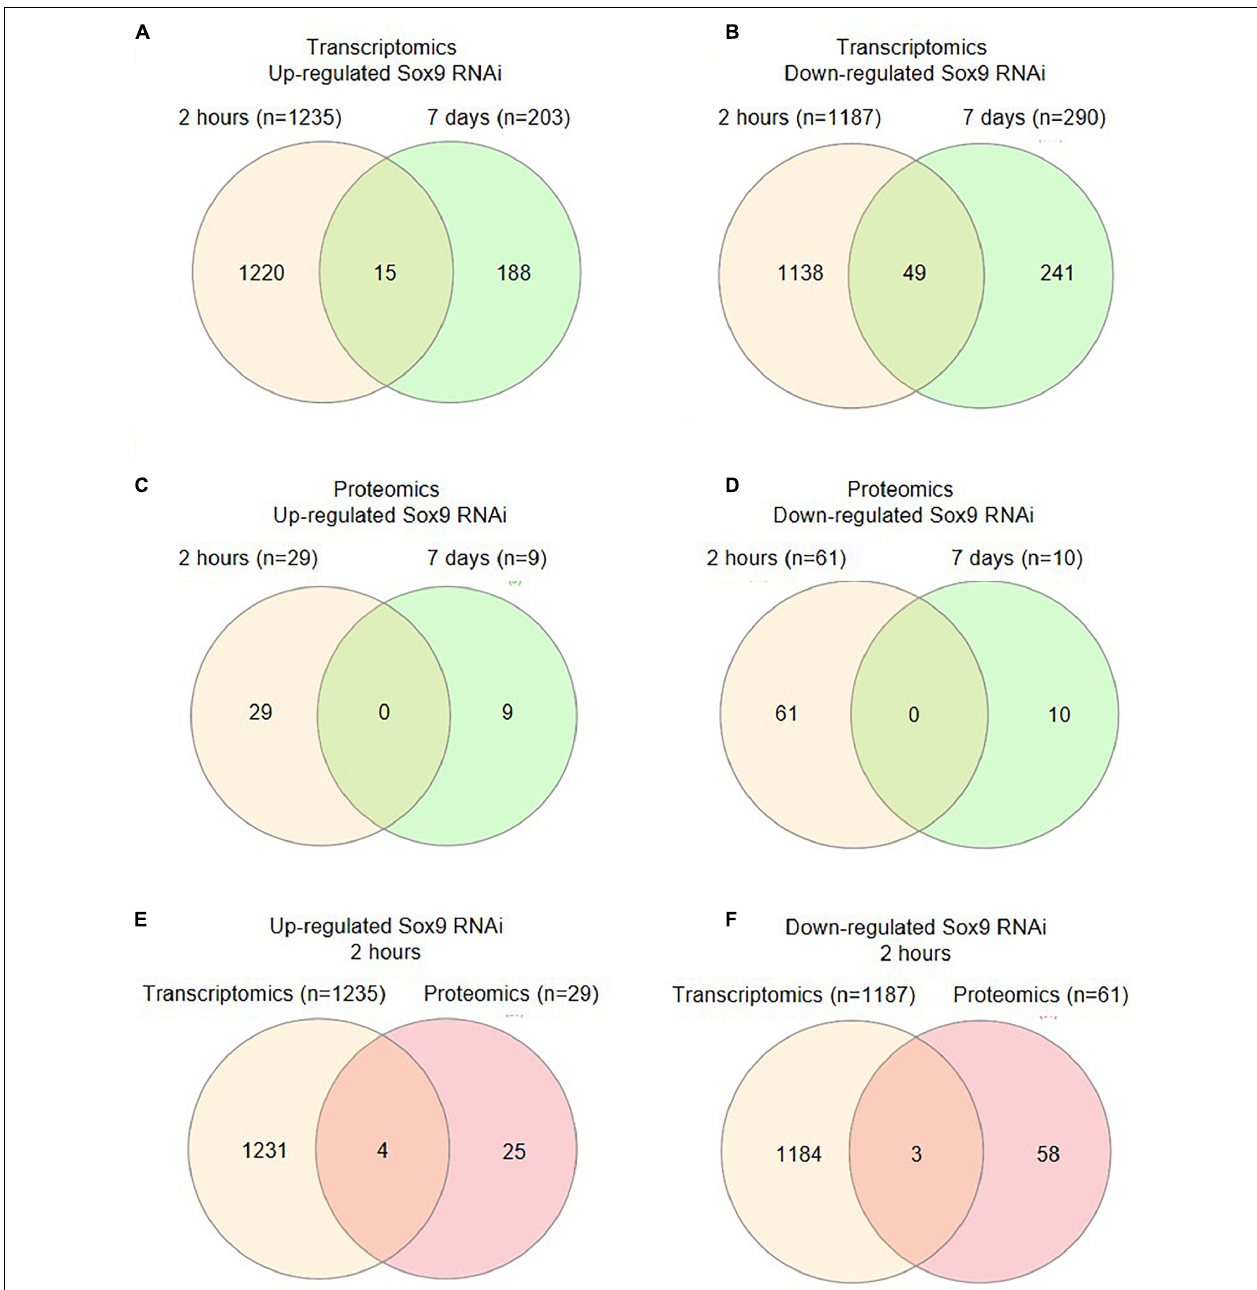
FIGURE 3 | Changes in transcriptome and proteome after Sox9 knockdown. (A) Venn diagram (Heberle et al., 2015) showing the numbers of genes whose expression was significantly upregulated upon Sox9 knockdown at 2-h versus 7-day condition. (B) Venn diagram showing the numbers of genes whose expression was significantly downregulated upon Sox9 knockdown at 2-h versus 7-day condition. (C) Venn diagram showing the numbers of proteins whose expression was significantly upregulated upon Sox9 knockdown at 2-h versus 7-day condition. (D) Venn diagram showing the numbers of proteins whose expression was significantly downregulated upon Sox9 knockdown at 2-h versus 7-day condition. (E) Venn diagram showing the upregulated genes versus proteins at 2 h in differentiation. (F) Venn diagram showing the downregulated genes versus proteins at 2 h in